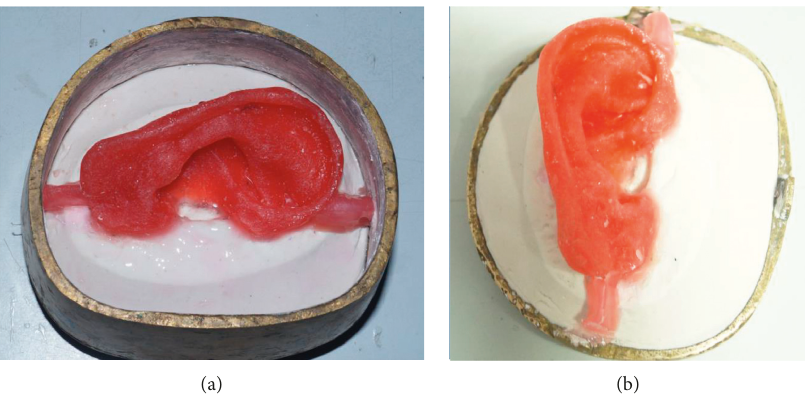
Figure 4: Fabrication using three piece mould